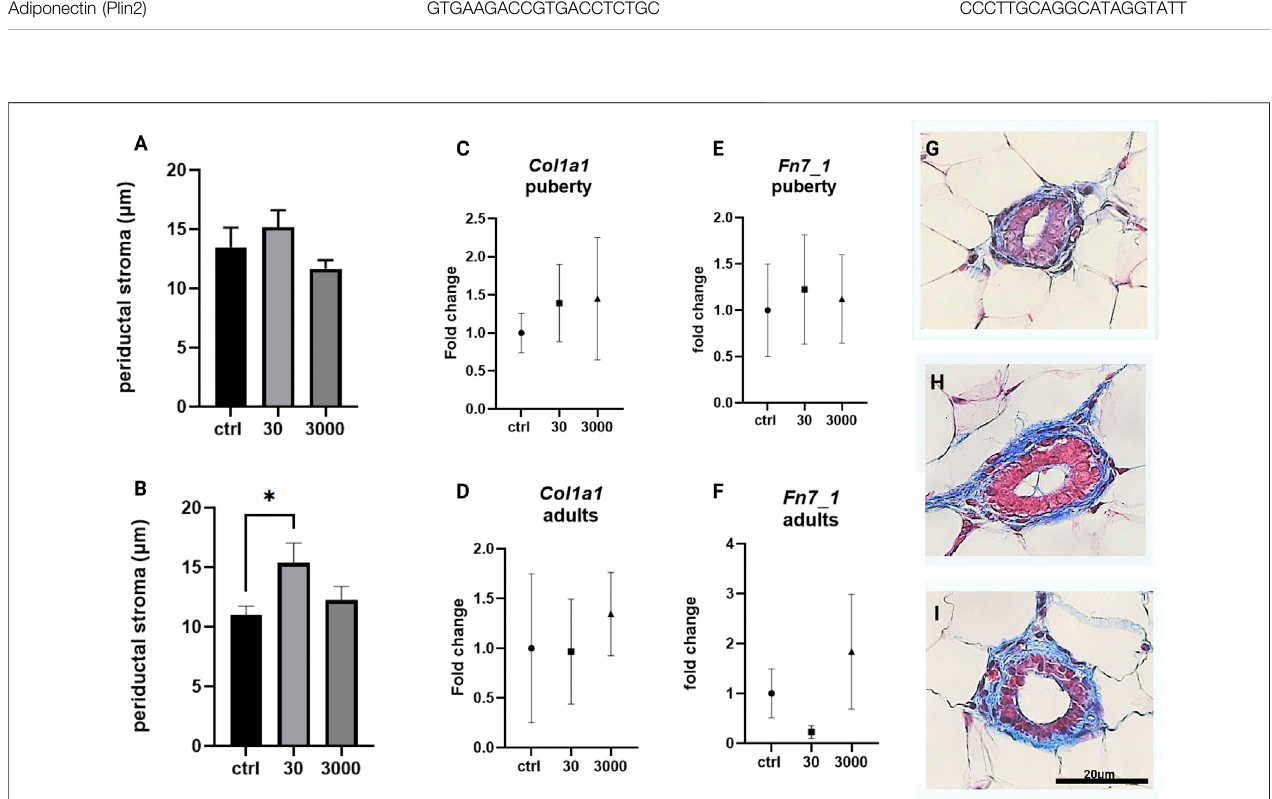
FIGURE2| Effectsofoxybenzoneonperiductalstroma, collagenand fi bronectin. (A) Thewidthofperiductalstroma atpuberty. (B) Thewidthofperiductalstroma inadulthood. (C) RelativemRNAexpressionofCol1a1mRNAatpuberty. (D) RelativemRNAexpressionofCol1a1mRNAinadulthood. (E) RelativemRNAexpressionof Fn7_1 mRNAatpuberty. (F) RelativemRNA expression ofFn7_1mRNAinadulthood. (G – I) Representativeimages ofperiductalstroma inadultanimals,incontrols (G) , andtreatmentgroupsof30 (H) and3000 μ g/kg/day (I) .Scalebar=20 µmineachimage.*indicatessigni fi cance < 0.05:ANOVA,Tukeyposthoctest.AllqRT-PCR expression data were normalized using the ΔΔ Ct